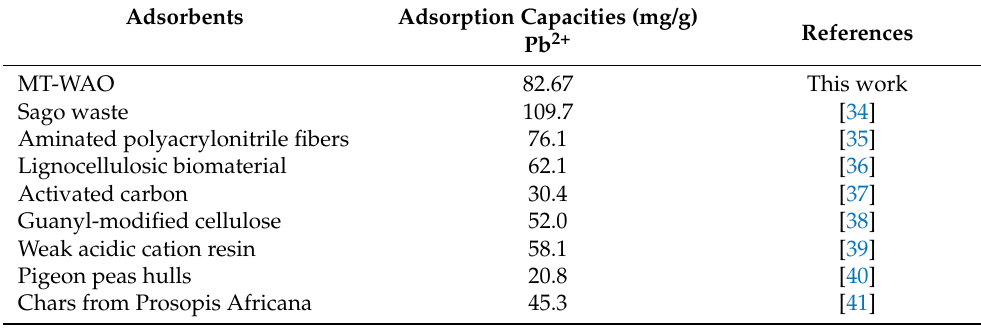
Table 4. Comparison of Pb 2+ and Cu 2+ adsorption performance of the MT-WAO with other adsorbents.